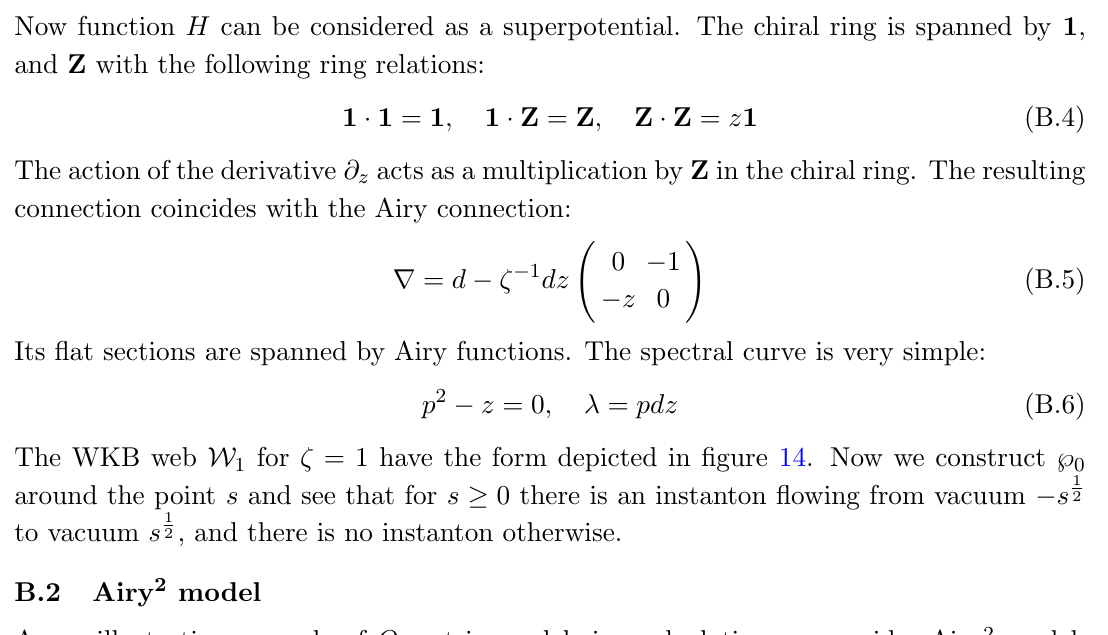
Figure 14 . Spectral curve for the Airy